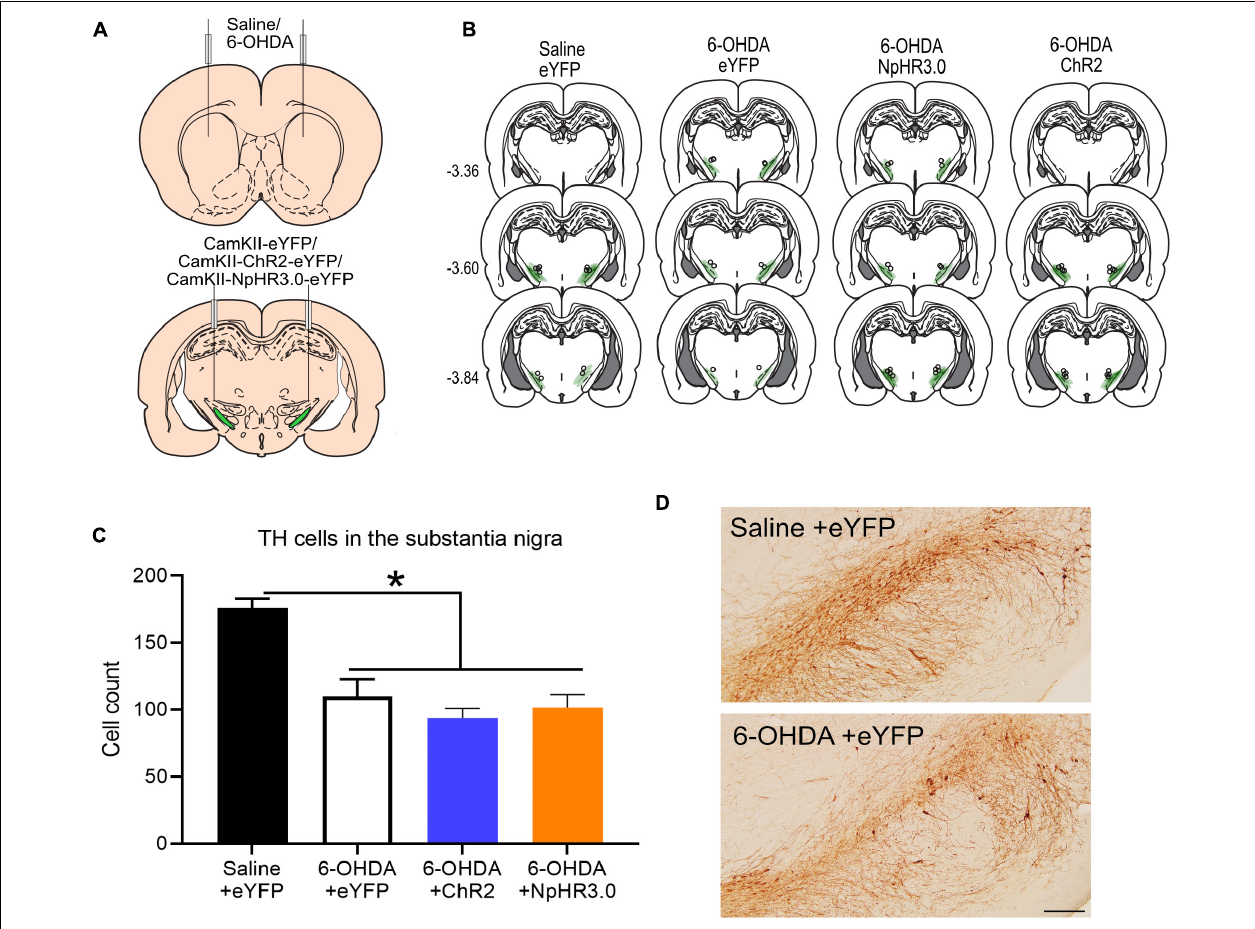
FIGURE 3 | Bidirectional regulation of subthalamic nucleus in dopamine in PD rodent model: Schematic of bilateral saline/6-OHDA administration in the striatum and optogenetic manipulation subthalamic nucleus (A) . Placement of viral expression and optic cannula in the STN (B) . Graph of tyrosine hydroxylase (TH)-immunoreactive cells in the substantia nigra in all groups (C) . Representative TH immunostaining from coronal sections of the substantia nigra in saline +eYFP and 6-OHDA + eYFP group. Scale bar: 200 µ m (D) . * p <